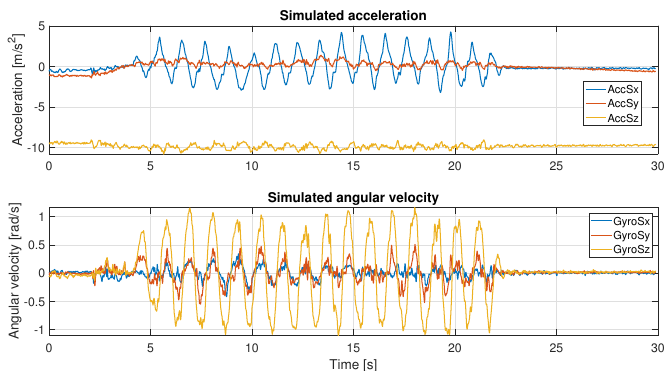
Figure 5. Simulated acceleration and angular velocity recording during horizontal